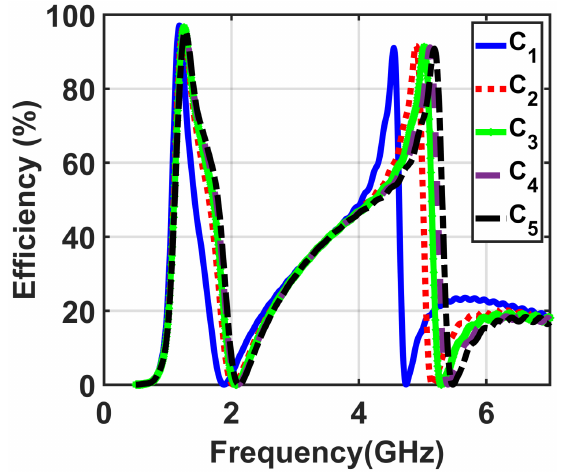
Figure 5. Obtained results of the efficiency of the five investigated cases for the values of the cuts from C 1 = 0.2 mm to C 5 = 0.6